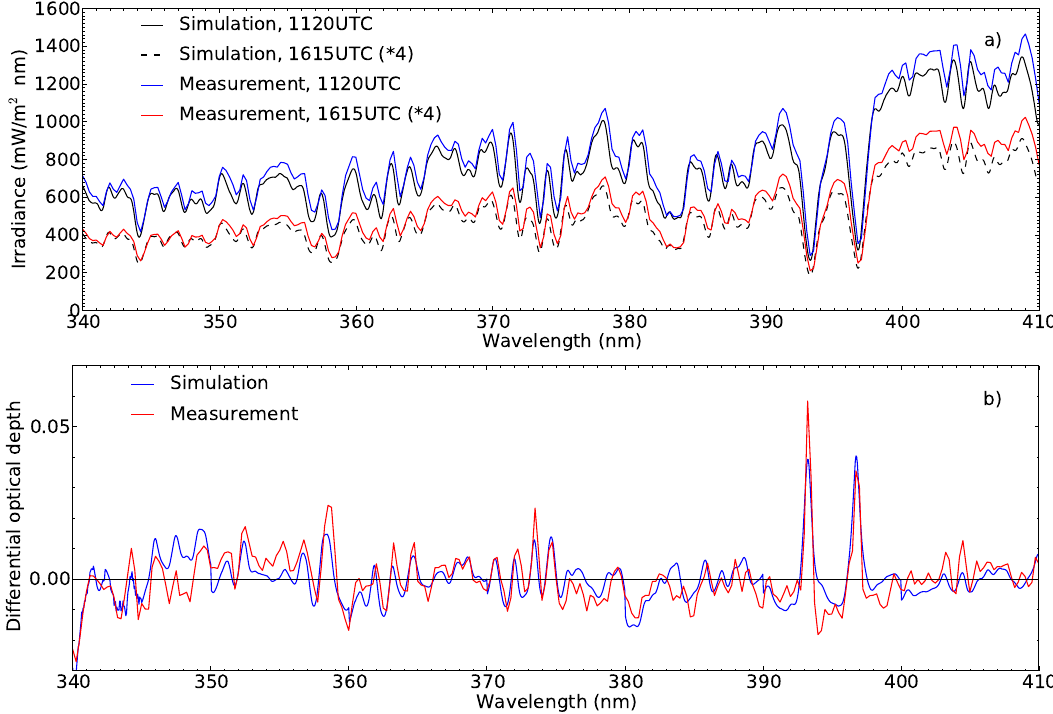
Fig. 10. (a) The measured spectra at 11:20 UTC (blue line) and 16:15 UTC (red line). The corresponding model simulations are shown in black. (b) The measured (red line) and simulated (blue line) DODs. Note difference in y-axis scale from Fig. 9b. The input parameters to the model simulation are described in the